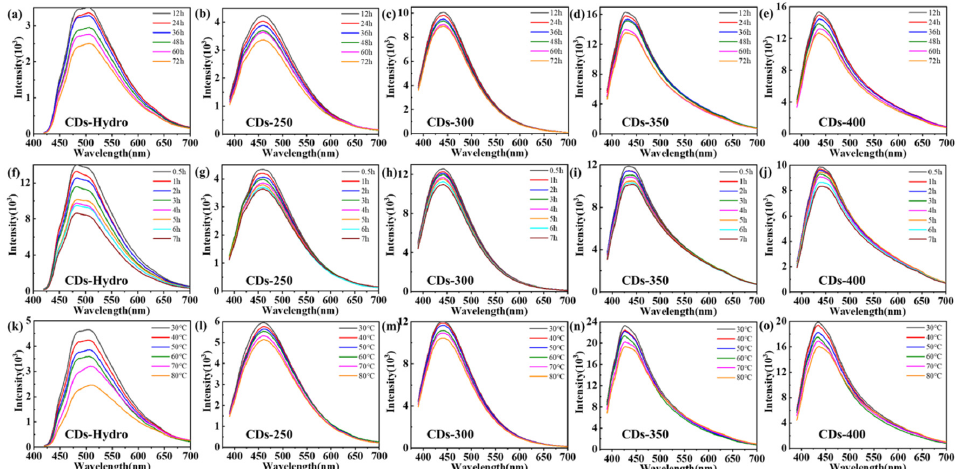
Figure 7. ( a – e ) PL emission spectra of CDs-Hydro, CDs-250-400 at different durations under visible light in ethanol solution. ( f – j ) PL emission spectra of CDs-Hydro, CDs-250-400 at different durations under ultraviolet light in ethanol solution. ( k – o ) PL emission spectra of CDs-Hydro, CDs-250-400 in a water bath at different temperatures in ethanol solution.